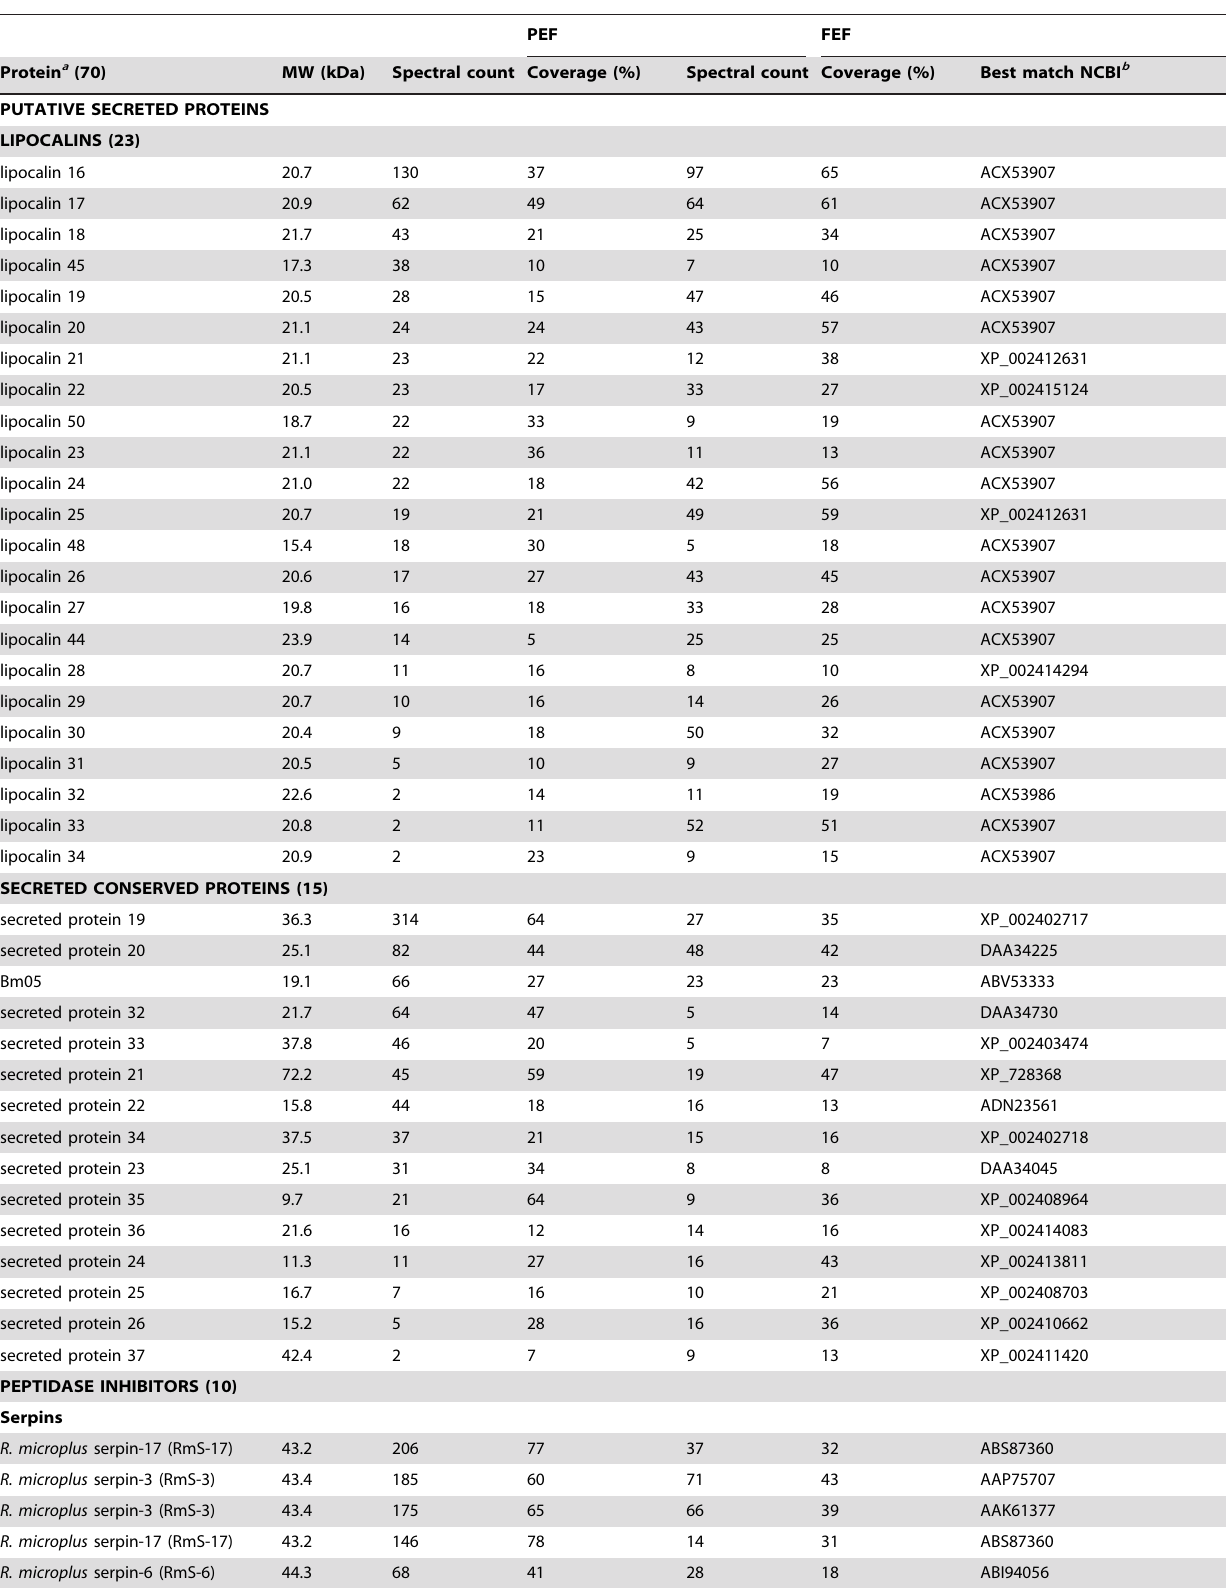
Table 3. Tick proteins identified both in PEF and FEF saliva by in solution digestion.